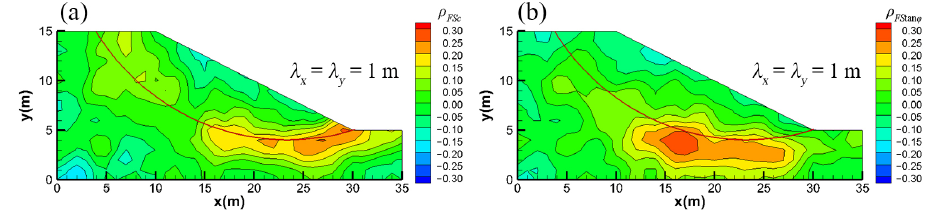
Figure 3. ( a ) Cross ‐ correlation map of FS and c , ( b ) Cross ‐ correlation map of FS and tan φ for statis ‐ tical